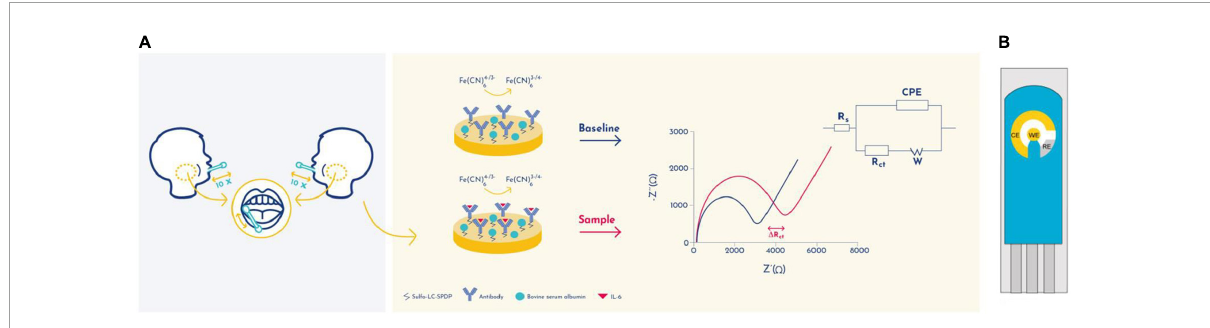
FIGURE1 Schematic representation of the detection principle of the EIS-based immunosensor. (A) Randles circuit was used to fit the electrochemical impedance data: electrolyte resistance (Rs), constant phase element (CPE), Warburg element (W), and charge transfer resistance (Rct). (B) A schematic representation of a gold screen-printed electrode system. CE, Counter Electrode; RE, Reference electrode; WE, Working electrode.